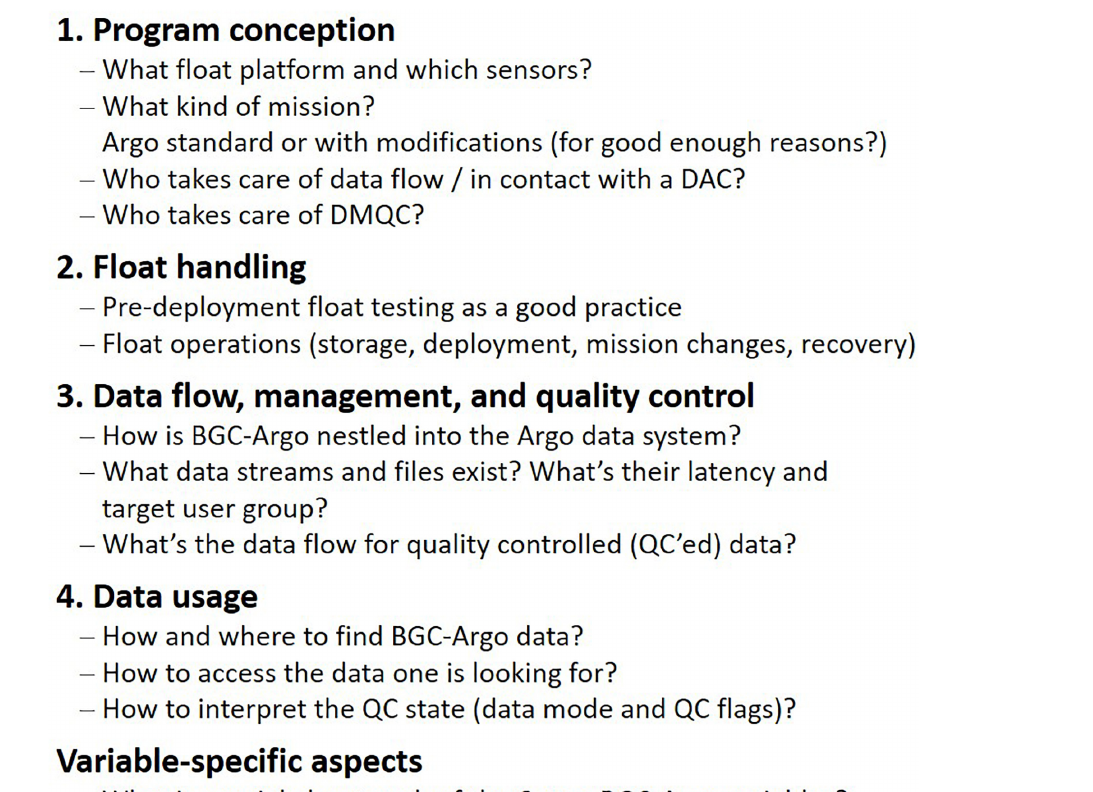
of observational platforms needed to constrain global air-sea CO 2 exchange (Biogeochemical-Argo Planning Group,